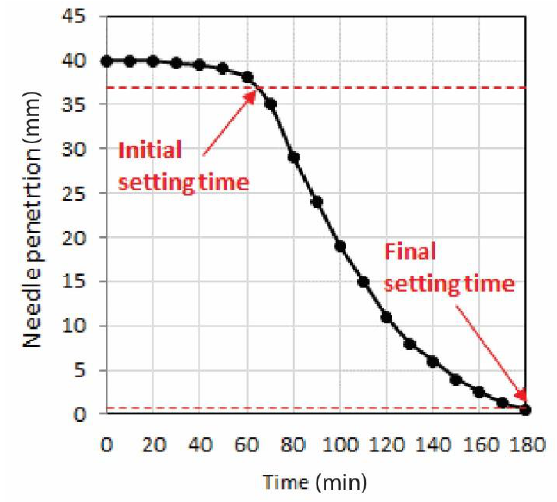
Figure 5. Vicat test of the cement paste consisting of cement, liquid solidification accelerator, Metakaolin, and water.